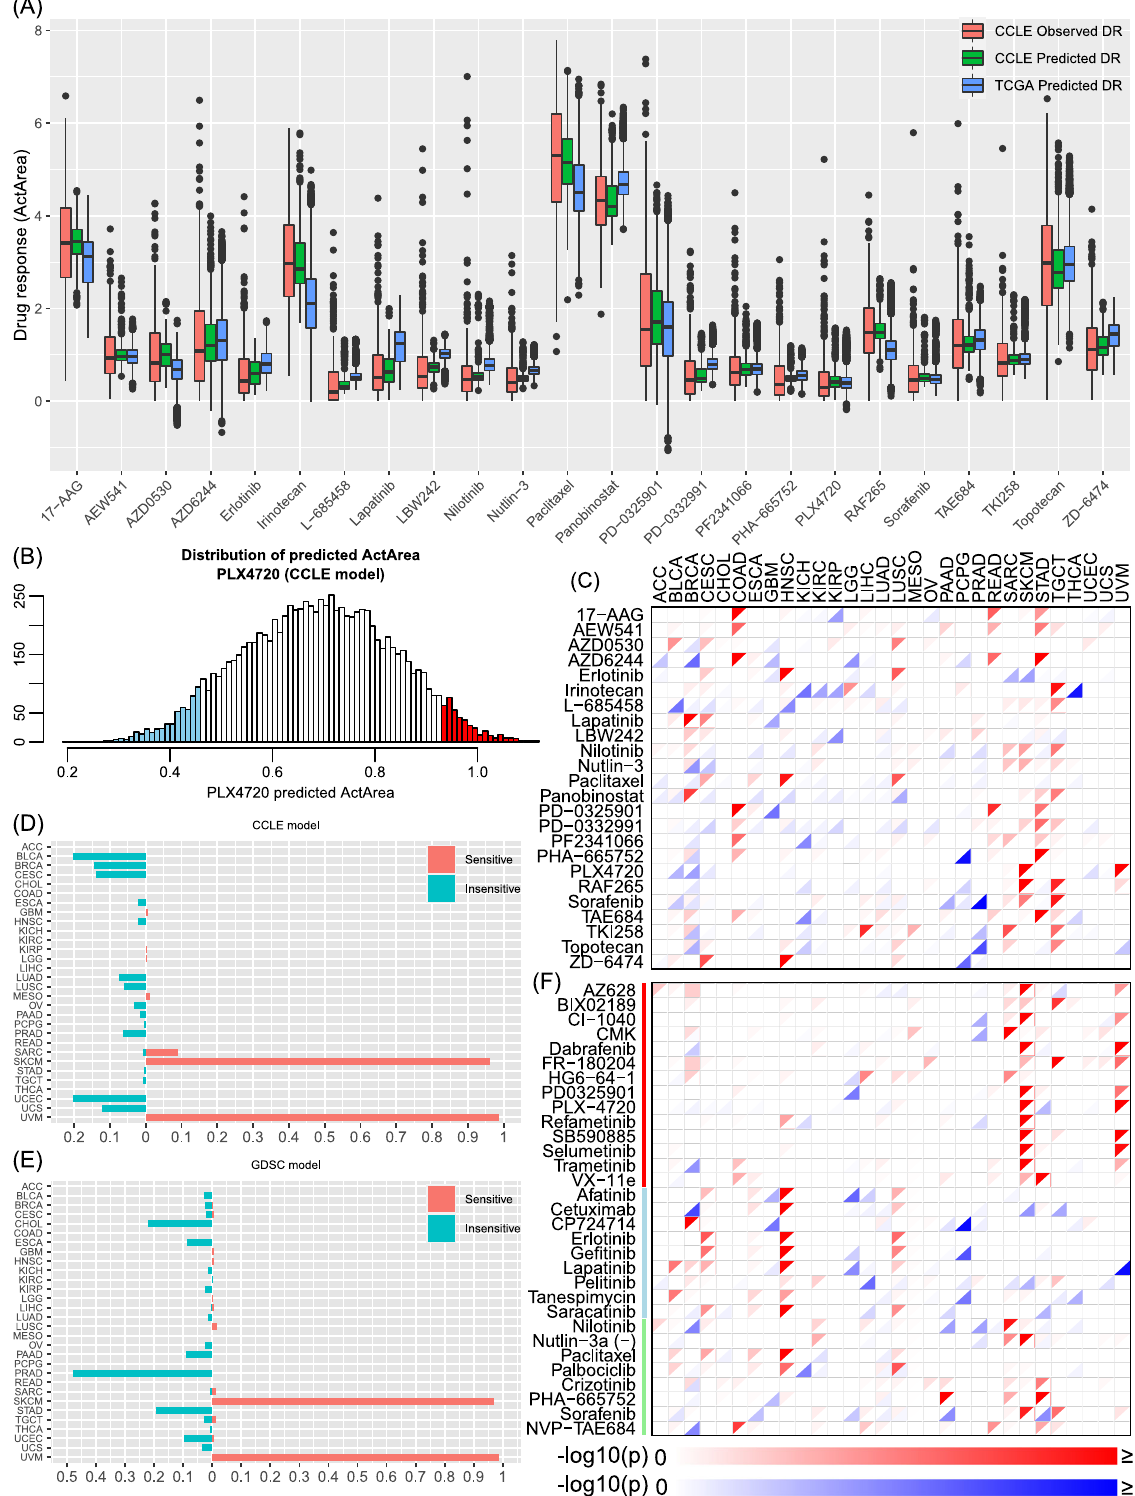
compounds. Here, we used CCLE to demonstrate the model performance. There were three drug-response pro fi le sets for each compound: the observed response in a limited number of cell lines (~500, set 1, red bars in Fig. 1E), the predicted response in the same cell lines as in set 1 (set 2, pink bars with the same occupancy as the red bars in Fig. 1E), and the imputed response in all cell lines (set 3, n = 1100, pink bars spanning all cell lines,